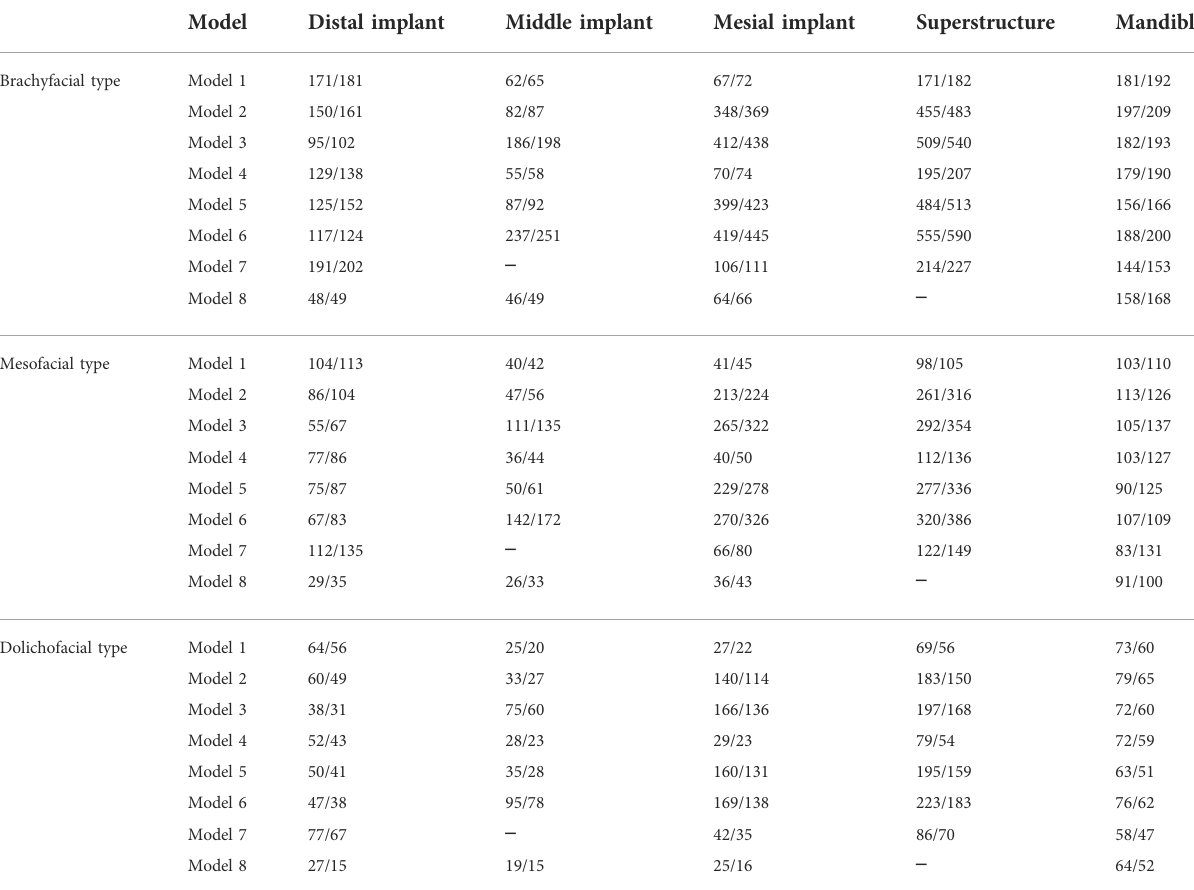
TABLE 8 Maximum von Mises stresses on the mandible and prostheses in different facial types and genders in the mandibular opening (male/ female) (MPa). Model Distal implant Middle implant Mesial implant Superstructure Mandible Brachyfacial